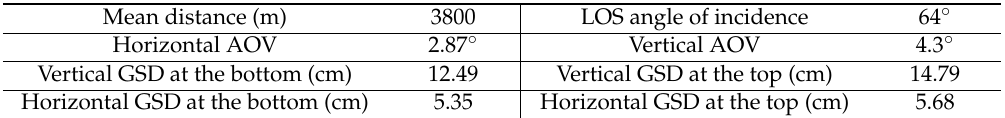
Table 3. Environmental and optical parameters of the system.